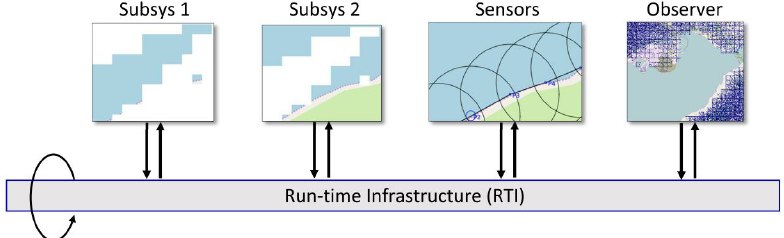
Figure 1. Federation of two complementary cellular subsystems, a sensor network, and some display for observation. A software bus (RTI) provides services for data exchanges, sequencing and synchronization. This framework is called High Level Architecture , standardized as IEEE Std 1516–2000